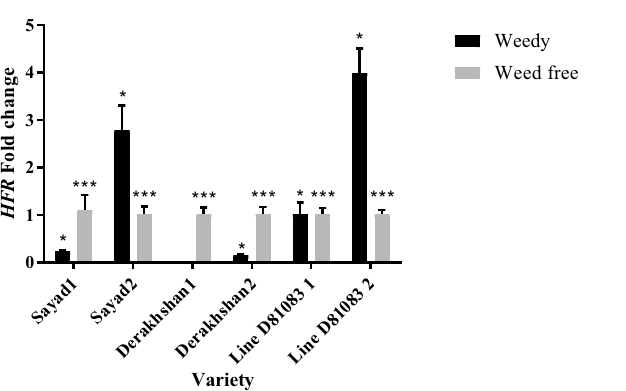
Figure 6. Real-time PCR (qRT-PCR) analysis of HFR gene transcript levels in two treatments weedy and weed free, in the three cultivars/lines studied and in two stages of sampling V4 and R7 (data are the mean ± standard error in five biological replications and five technical replications, numbers 1 and 2 next to the name of the cultivar represent the V4 and R7 stages, respectively). ***: P < 0.99; **: P <